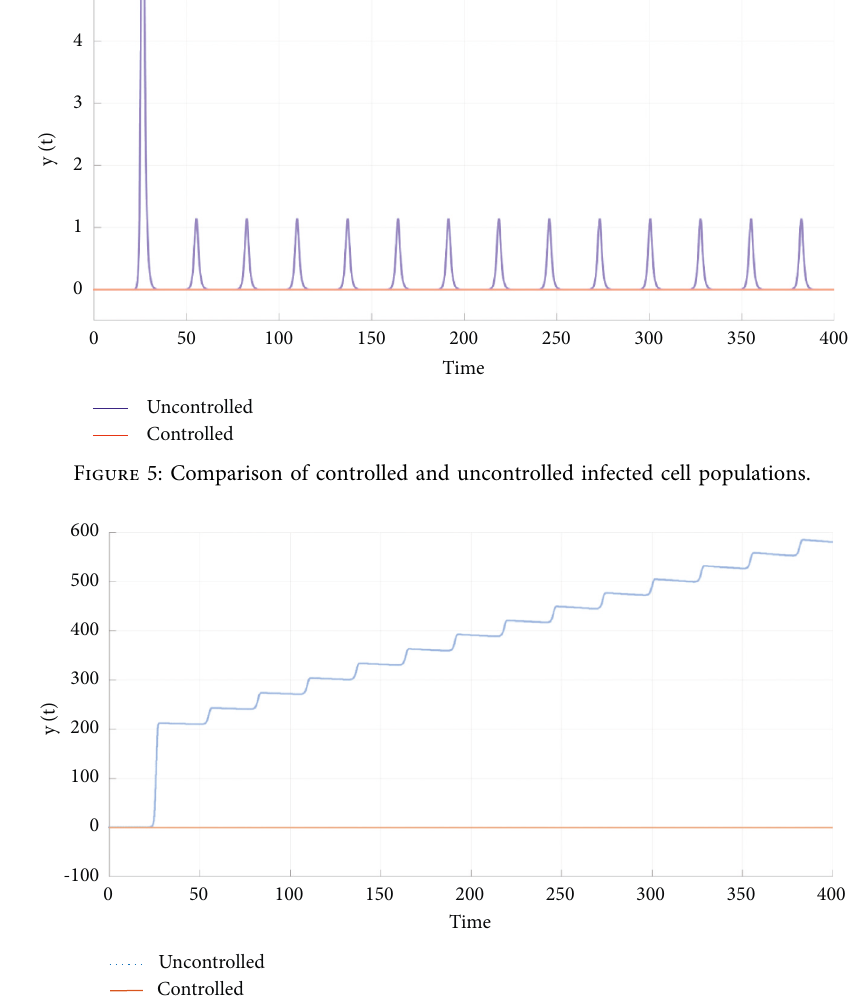
Figure 6: Comparison of controlled and uncontrolled latent cell